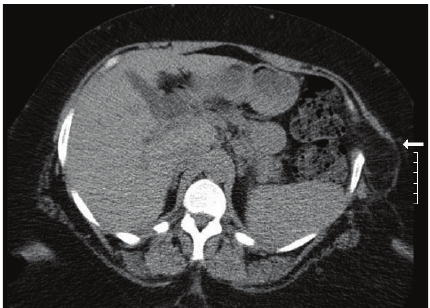
Figure 3: Exposure of the hernia sac.